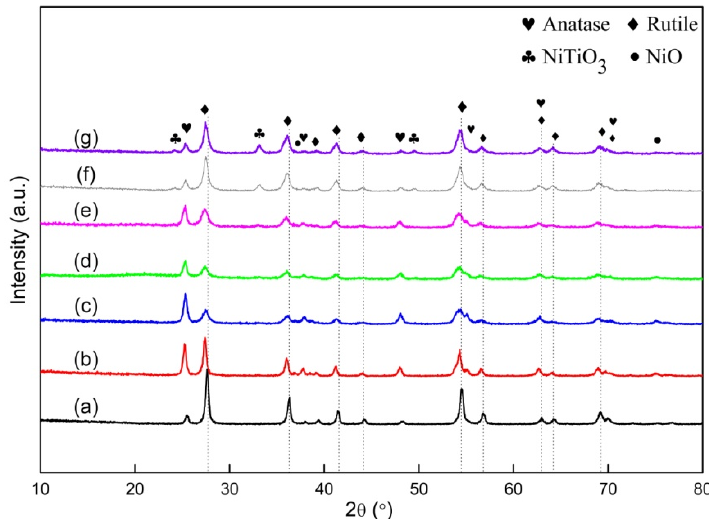
Figure 2. XRD patterns of ( a ) pristine TiO 2 , ( b ) 1 wt.% Ni-doped TiO 2 , ( c ) 3 wt.% Ni-doped TiO 2 , ( d ) 3.5 wt.% Ni-doped TiO 2 , ( e ) 4 wt.% Ni-doped TiO 2 , ( f ) 6 wt.% Ni-doped TiO 2 , and ( g ) 10 wt.% Ni-doped TiO 2 .